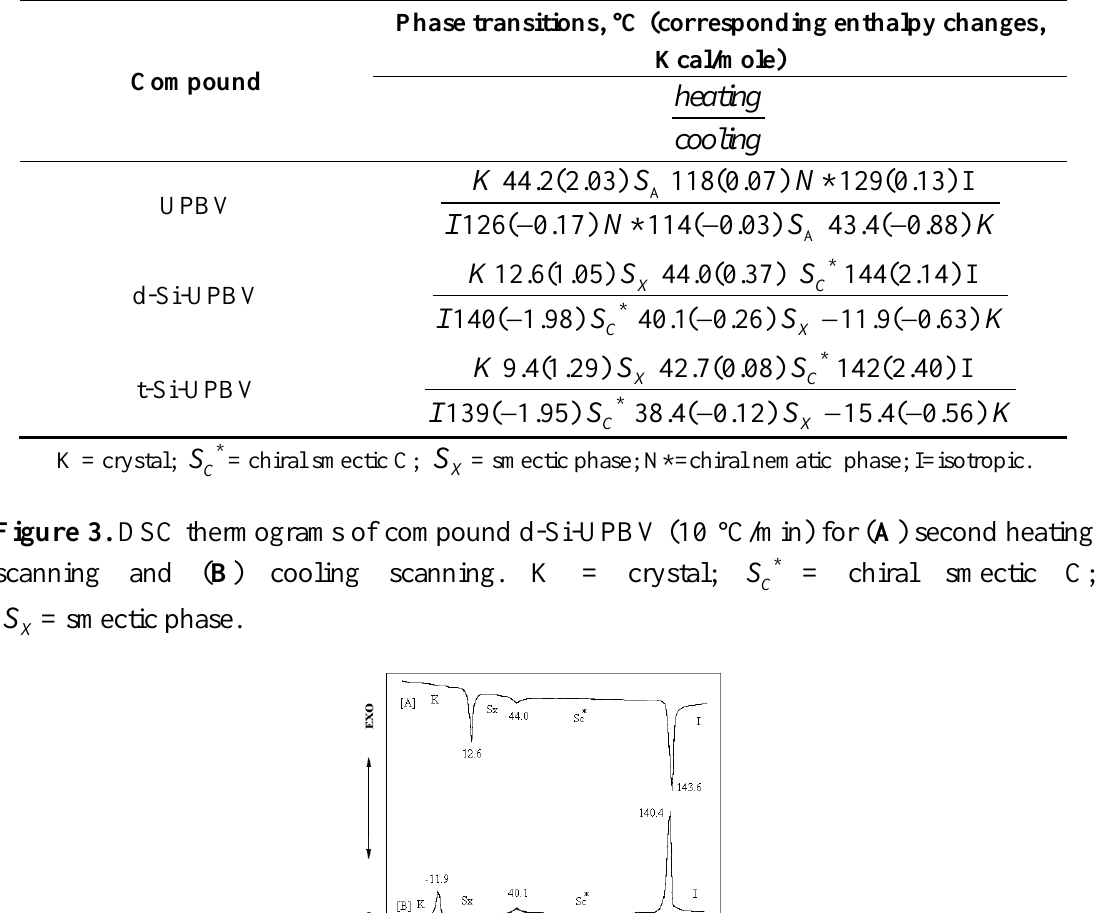
Table 2. Thermal transitions of compounds UPBV, d-Si-UPBV and t-Si-UPBV.